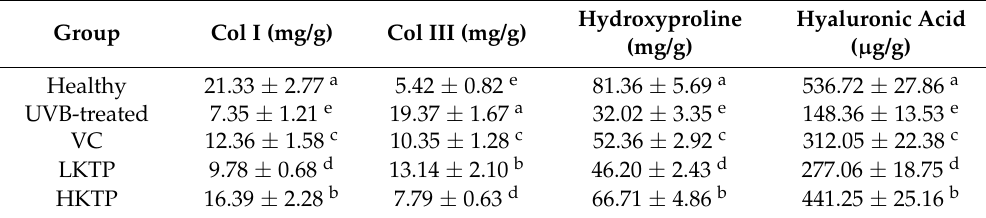
Table 4. Col I, Col III, hydroxyproline, and hyaluronic acid in the skin tissue of SKH1 hairless mice with UVB-induced skin aging.